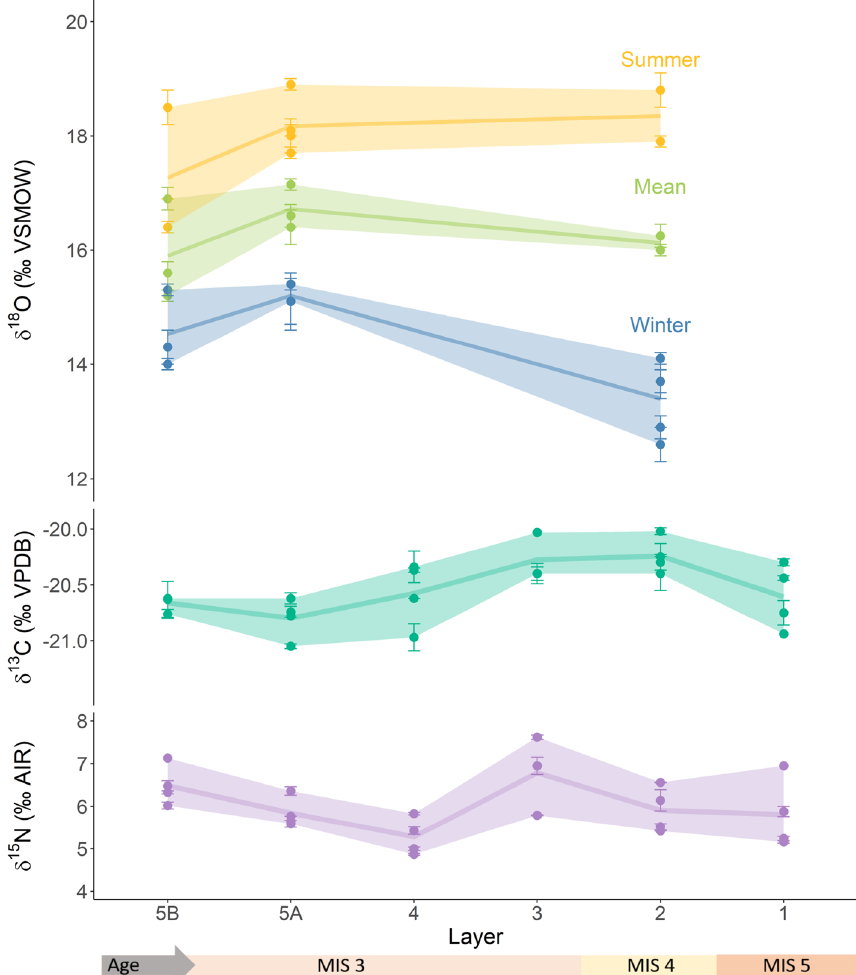
Figure 1. Correlated changes in δ 18 O from tooth enamel (top) and δ 13 C from bone collagen (middle) reflect minimal environmental changes across archaeological layers at La Ferrassie. Summer (yellow), mean annual (green) and winter (blue) δ 18 O values are shown as individual points with a line connecting the layer means and a ribbon visualizing the maximal spread of the data. Summer peak and winter trough values are derived from sinusoidal δ 18 O curves and are shown in Supplementary Figure S8. Mean annual points represent the average of peak and trough values, analogous to the calculation of modern mean annual temperatures. Summer temperatures and mean annual conditions stay stable between Layer 2 and 5. Winter temperatures show small differences between Layer 2 and Layers 5A and 5B, and are lowest and most variable in Layer 2. Diachronic in δ 13 C and δ 15 N values are congruent with small changes in winter δ 18 O and support that each system robustly reflects an overall picture of relatively homogeneous temperature, soil isotope values and/or plant community structure with only subtle changes between